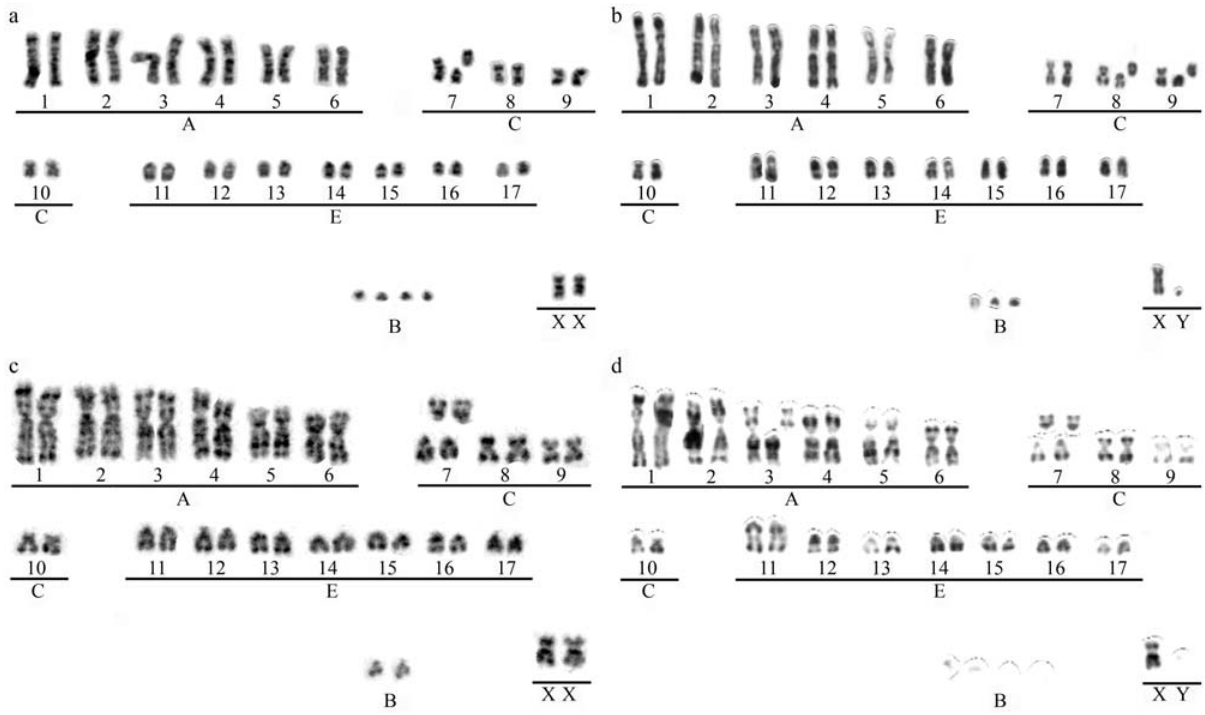
Figure 2 - G-banded karyotypes of Mazama nana : (a) V03, pair 7 is heterozygous for a centric fusion (2n = 37+4B; FN = 58); (b) V04, pairs 8 and 9 are heterozygous for centric fusions (2n = 38+3B; FN = 58); (c) V05, pair 7 is acrocentric (2n = 38+2B; FN = 58); (d) V07, pair 3 is heterozygous for a centric fusion and pair 7 is acrocentric (2n = 39+4B; FN =